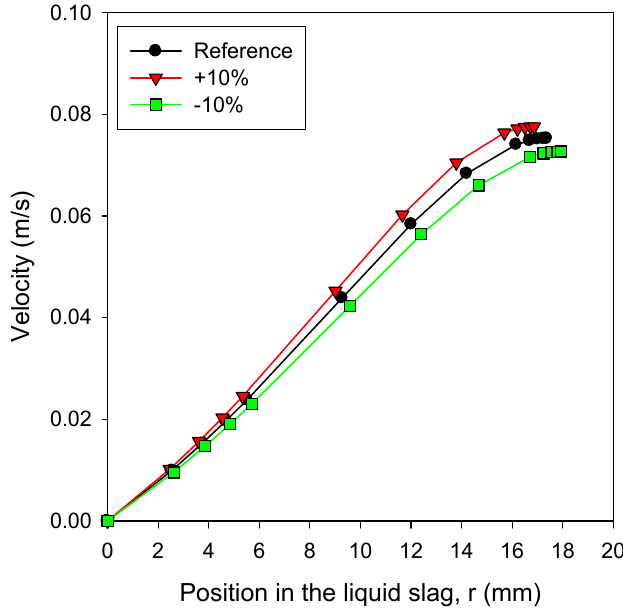
Figure 6. Effects of bottom cone height on velocity distribution of liquid slag at the slag